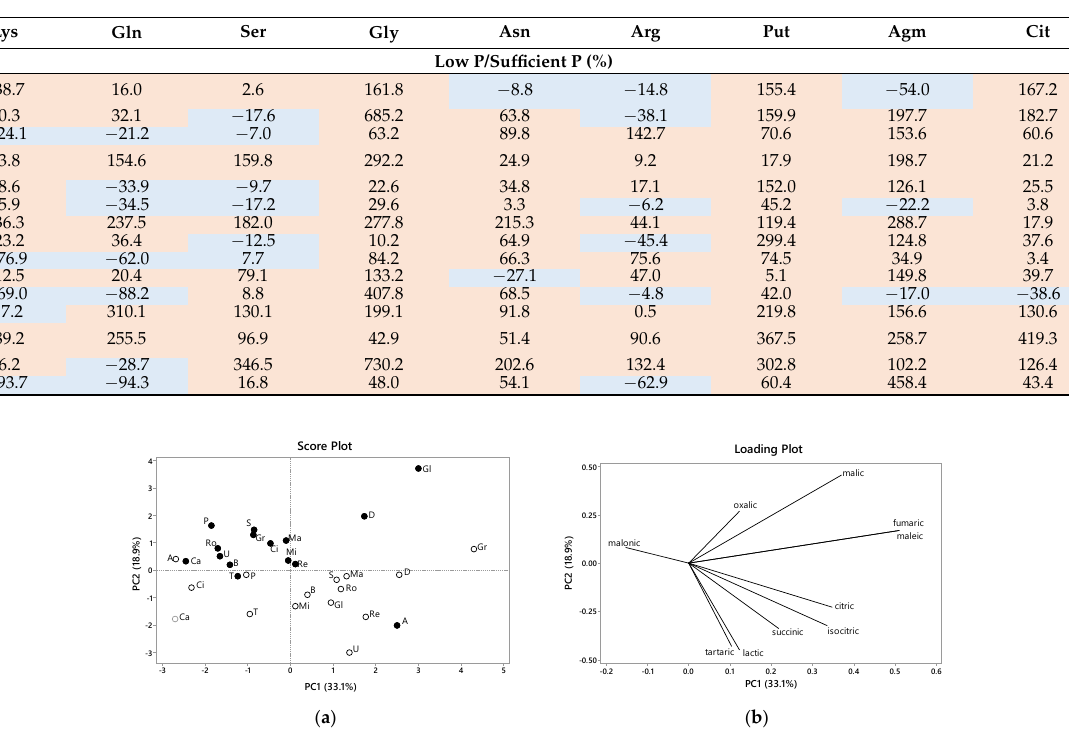
Table 2. Percentage of change between the amount of individual amino acids/polyamines exuded by roots under low and sufficient phosphorus concentrations in each eucalypt species. Blue-shaded cells indicate a decrease and orange-shaded cells indicate an increase in the percentage of change.